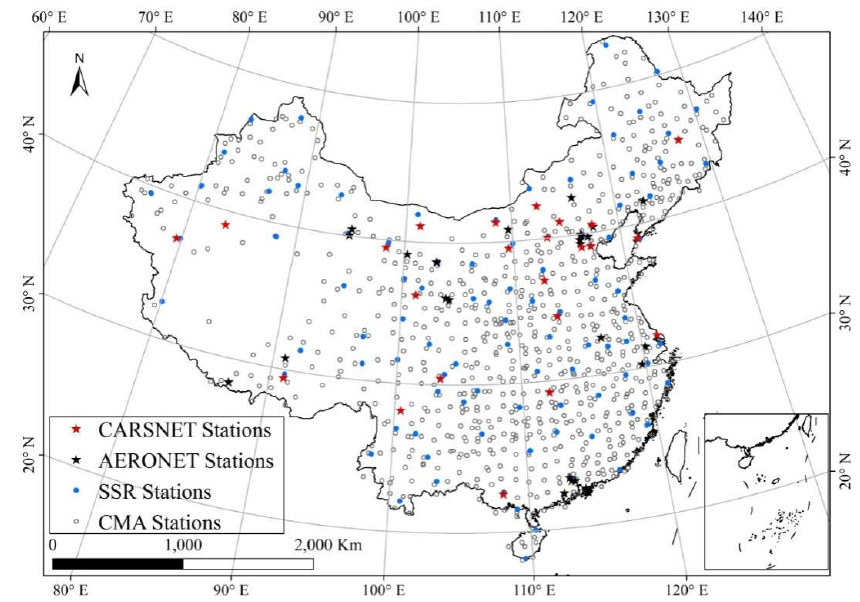
Figure 1. Spatial distribution of the CARSNET, AERONET, SSR and CMA stations used in this study. Table 1. Geographical and annual mean meteorological data at CARSNET, AERONET, SSR and CMA